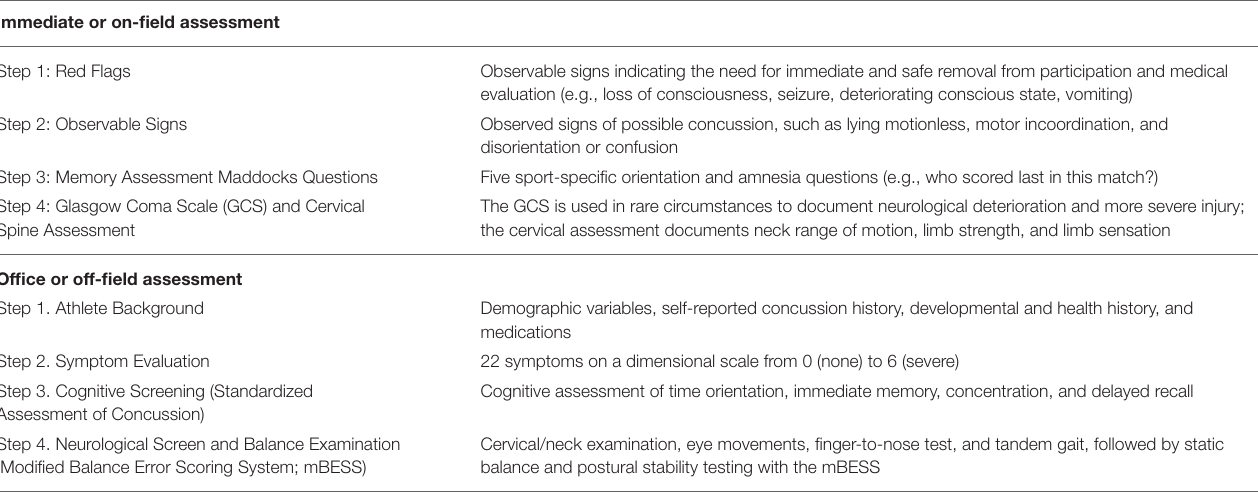
TABLE 1 | Components of the SCAT5 (Echemendia et al.,